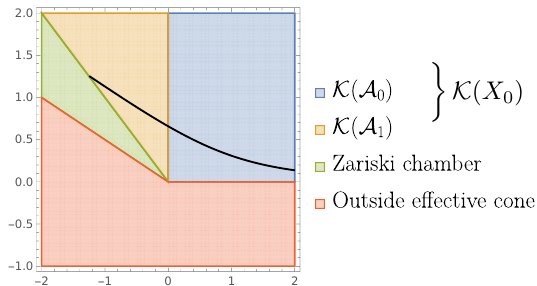
Figure 5 . Effective cone of THCY example (17 , · ) , showing Kähler cone of CY X 0 , which is a union of ambient space Kähler cones for two triangulations, as well as an adjacent Zariski chamber, with a geodesic curve superimposed.